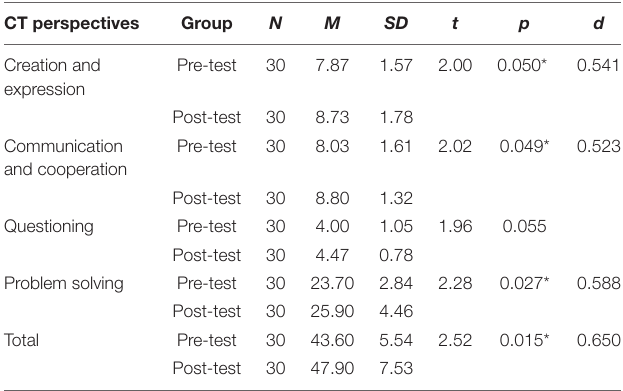
TABLE 14 | The paired sample t -test of the EG’s CT perspectives pre-test and